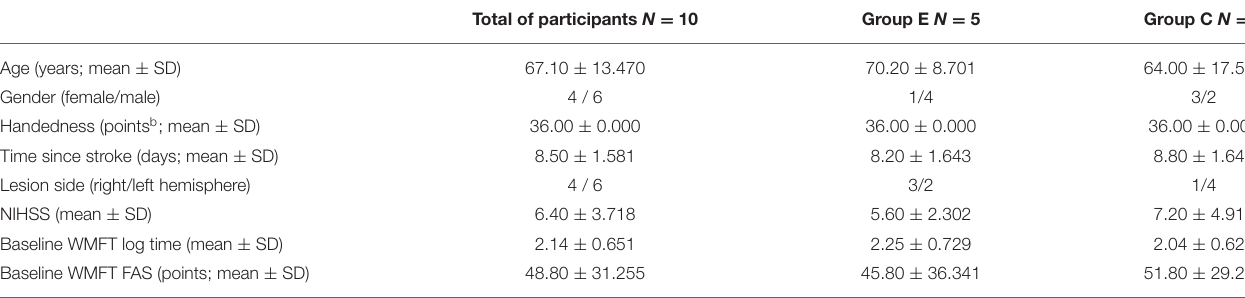
TABLE 1 | Clinical and demographic data of volunteers a